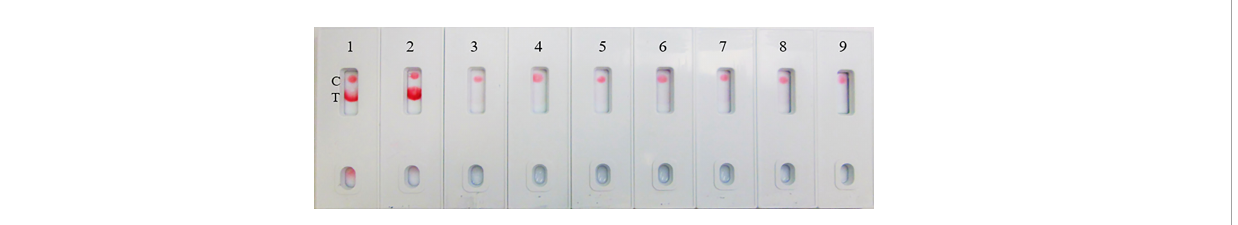
FIGURE 6 LFIA Speci fi city/Cross-reactivity with Corona Virus Panel. 1. NR-52397 SARS-CoV-2 spike protein (positive control), 2. NR-52366 SARS-CoV-2 RBD protein (positive control), 3. NR-52286 Heat inactivated SARS-Related Coronavirus 2, Isolate USA-WA1/2020, 4. NR-52289 SARS-Related Coronavirus 2,